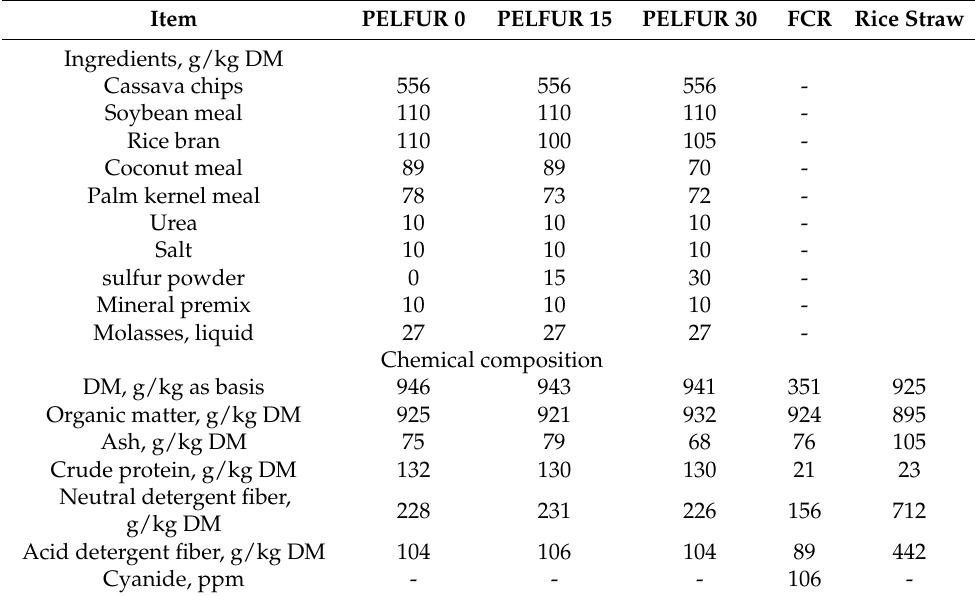
Table 1. Ingredient and chemical composition of pellets containing high sulfur (PELFUR) in the experiment (g/kg dry matter,